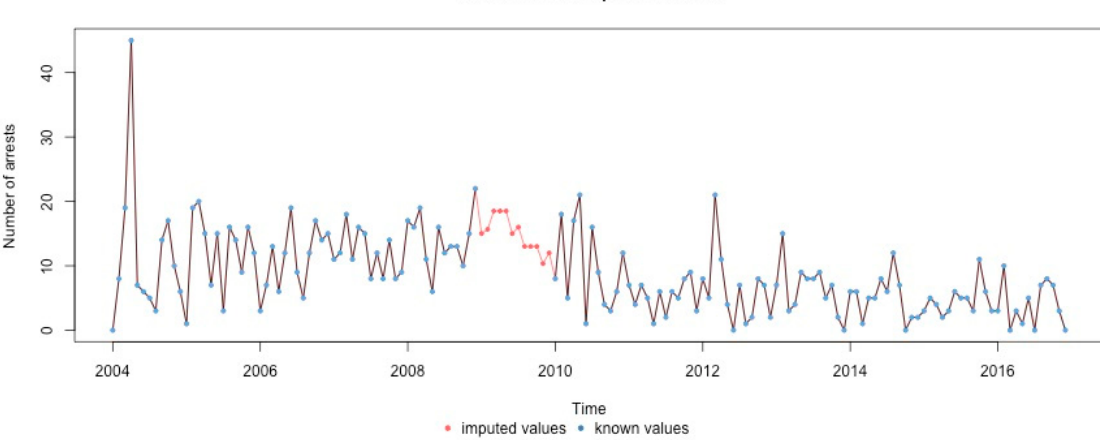
Figure A16. Heroin arrests 2004–2016 in the Czech Republic – imputed missing values.